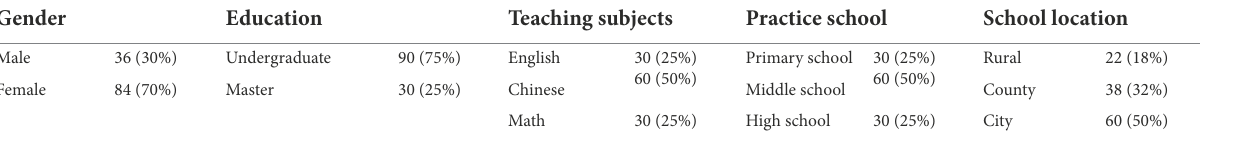
TABLE 1 Descriptive statistics ( n =